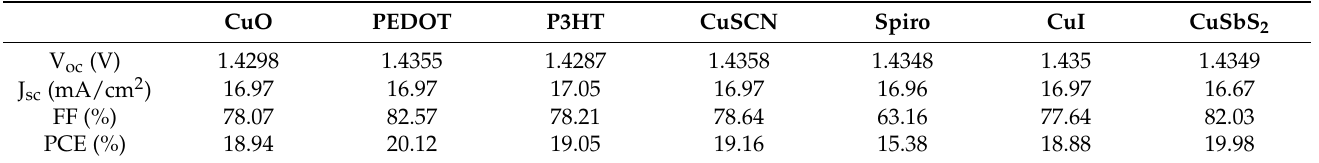
Table 2. Comparison of performance of different configurations for different HTLs with WS 2 ETL and Cs 3 Bi 2 I 9 absorber